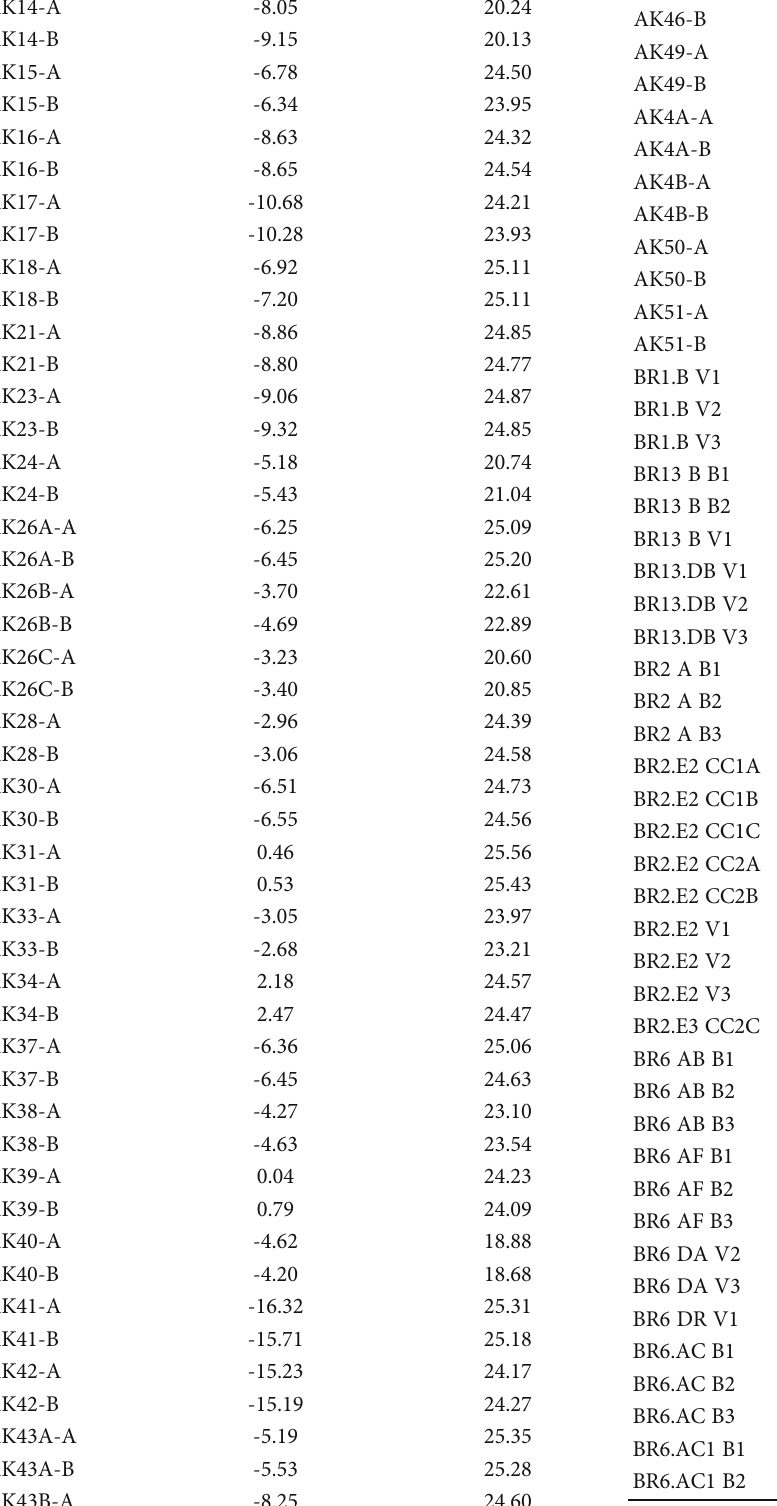
Table 5: Calculated δ 13 C ratios of hydrothermal carbonate phases from Akatore Creek and Bruce Rocks.